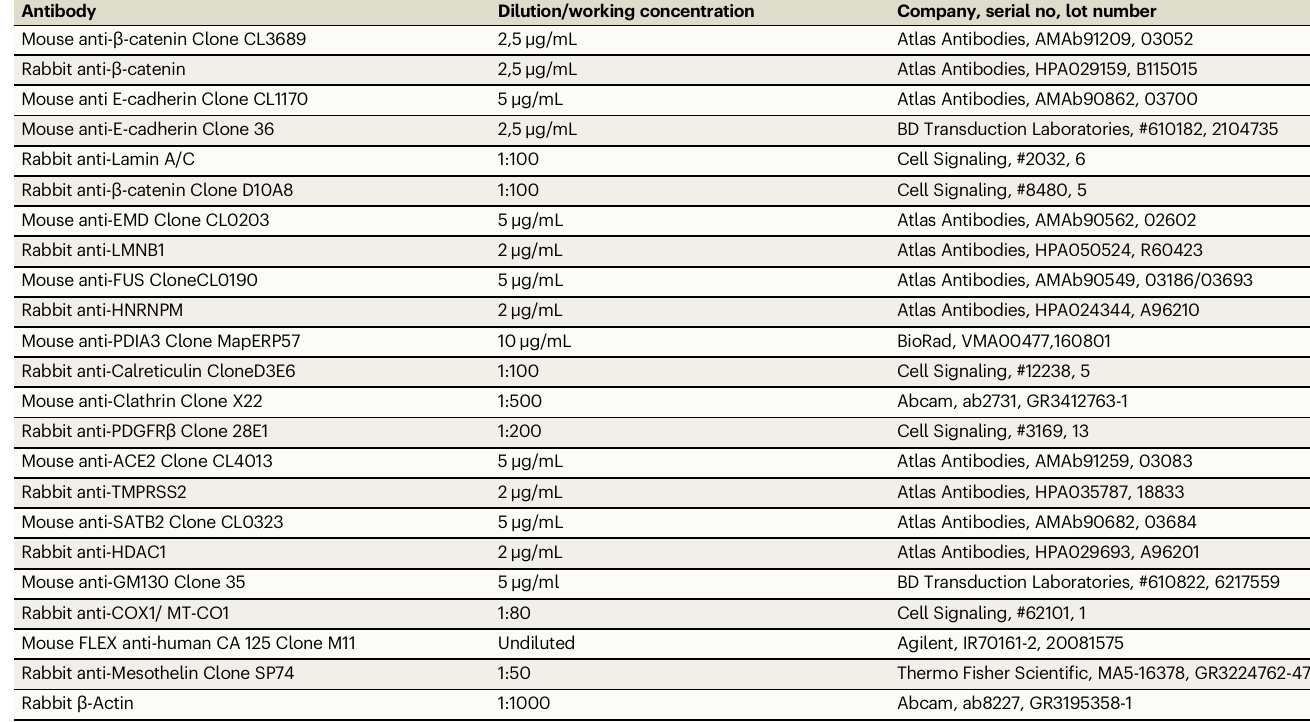
Table 2 | Antibodies used for MolBoolean